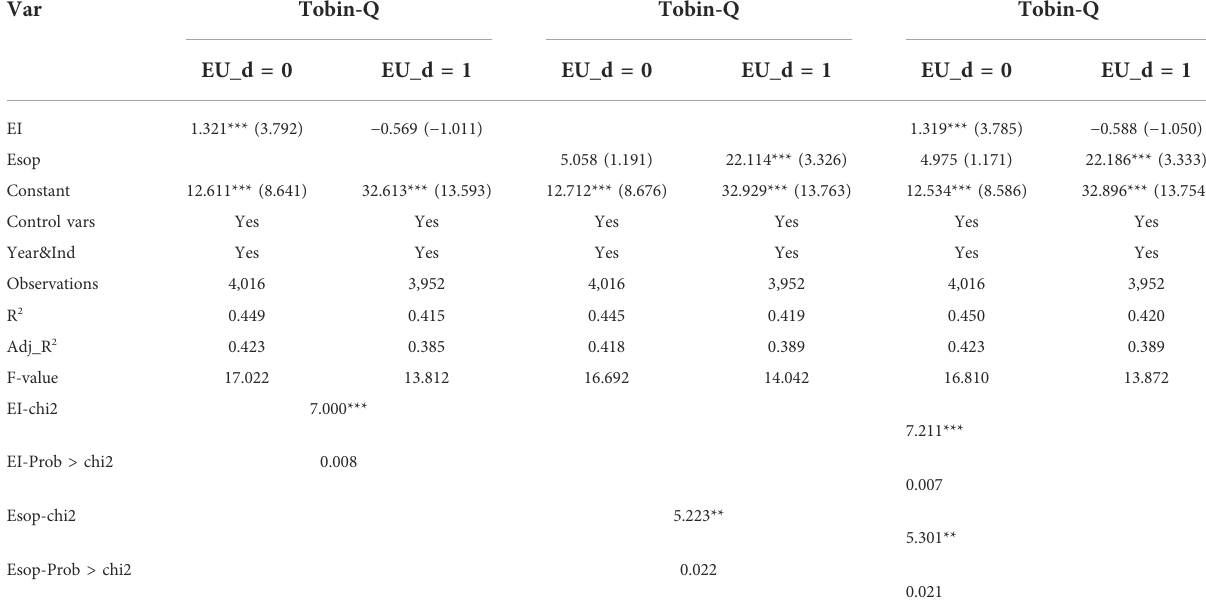
TABLE 11 Tobin-Q of models (2) – (4)